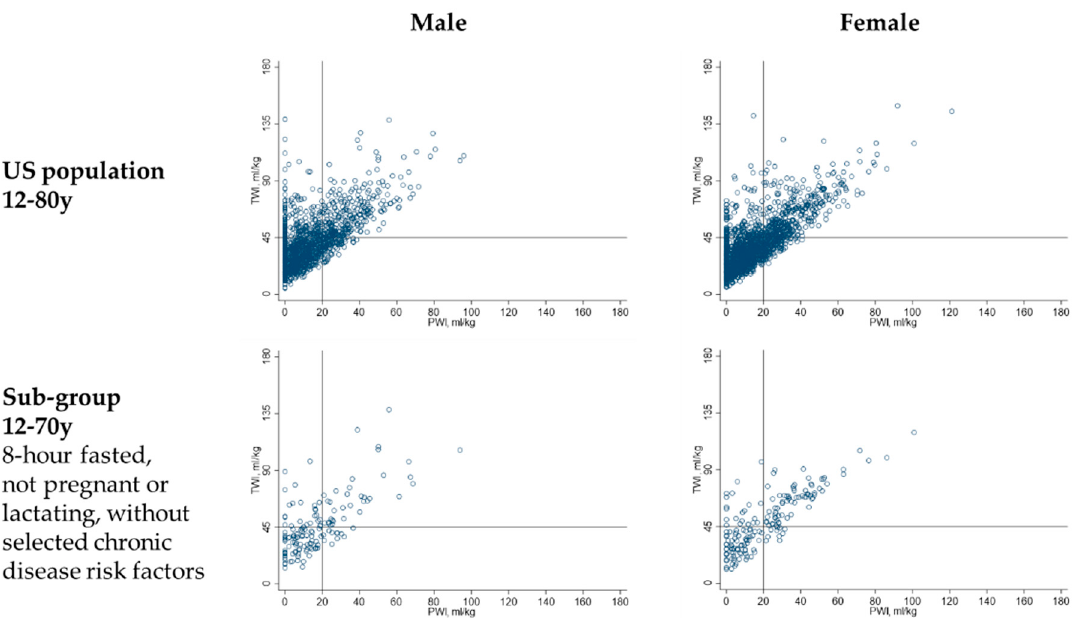
Figure 4. Relationship between TWI and PWI for US males and females who met the hydration criteria in 2009–2012. Each dot represents the total water intake (TWI) and plain water intake (PWI) of one NHANES 2009–2012 participant.